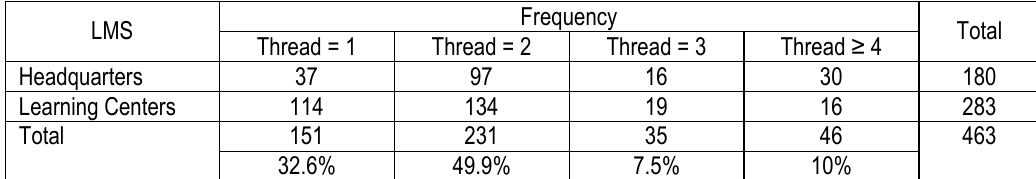
Table 7. SHTVU LMS: Thread Levels of Discussions